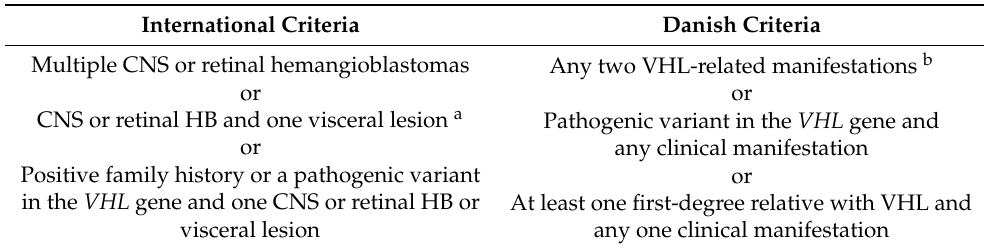
Table 1. Clinical criteria for the diagnosis of Von Hippel–Lindau disease based on the International and Danish VHL diagnostic criteria. International Criteria Danish Criteria Multiple CNS or retinal hemangioblastomas Any two VHL-related manifestations b or or CNS or retinal HB and one visceral lesion a Pathogenic variant in the VHL gene and or any clinical manifestation Positive family history or a pathogenic variant or in the VHL gene and one CNS or retinal HB or At least one first-degree relative with VHL and visceral lesion any one clinical